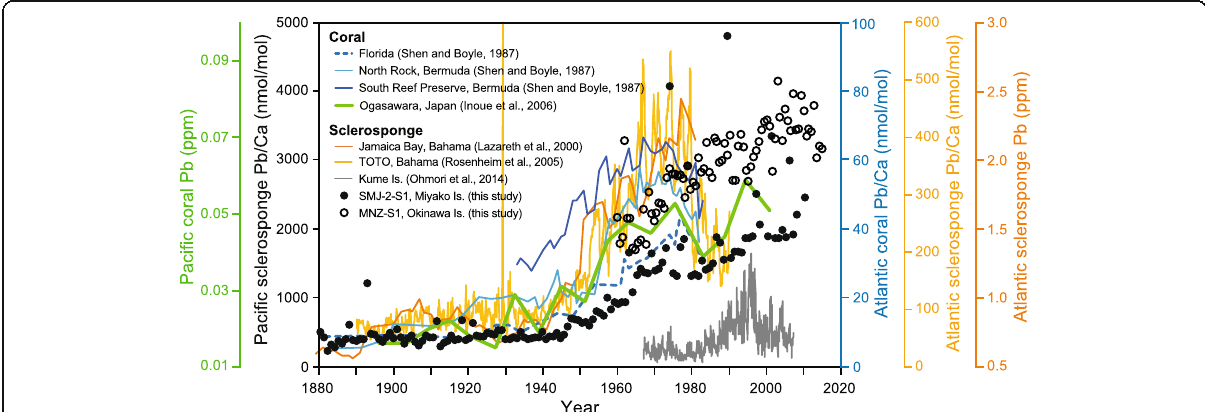
Fig. 10 Secular Pb/Ca and Pb concentration variations in sclerosponges and corals from the Pacific and Atlantic